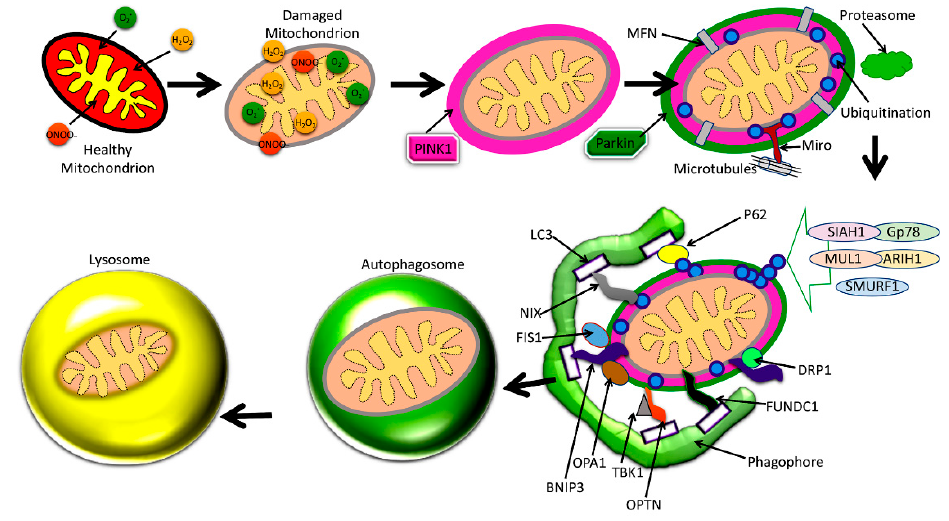
Figure 5. Proteins involved in autophagy and mitophagy in a cell. Figure depicts overall autophagy and mitophagy events and